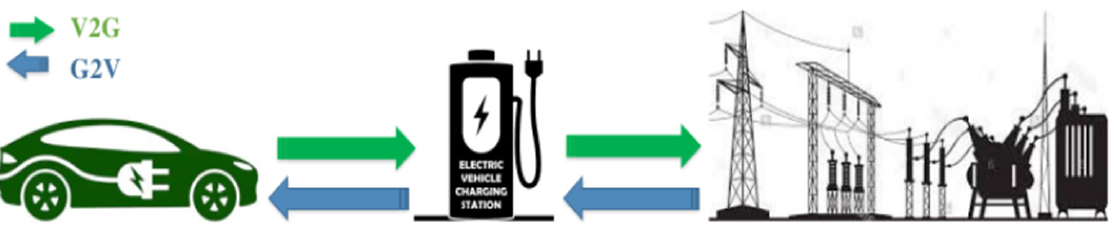
Figure 4. G2V & V2G Energy flow.